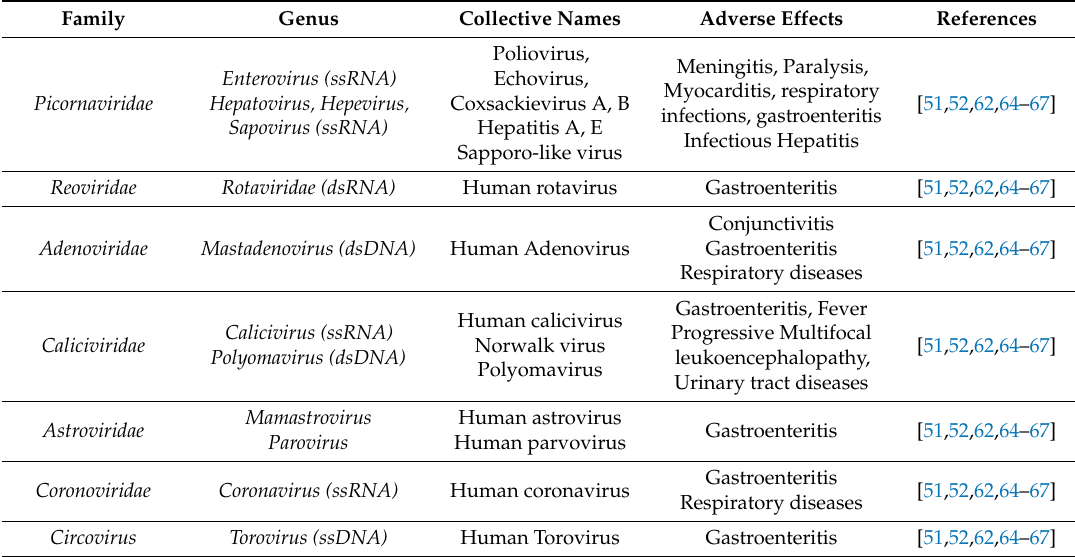
Table 1. Human enteric viruses (HEV) that have been identified in various aquatic